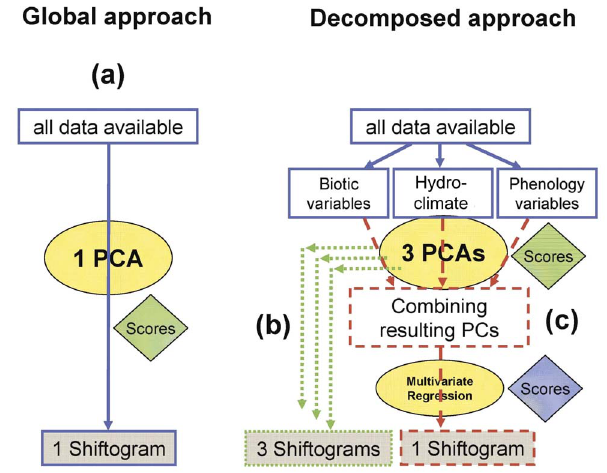
Figure 1. The analysis algorithm (a) for the global approach by applying a PCA based on all variables and generating one shiftogram using the resulting PC1 only, (b) for the decomposed approach by applying three PCAs (one per each factor grouping) and thus generating three shiftograms based on the three resulting PC1’s, (c) for the decomposed approach by additionally combining all PCs produced in (b) using multivariate regression and generating one shiftogram based on the predicted values of PC1 of the biotic PCs (see eq. 3).